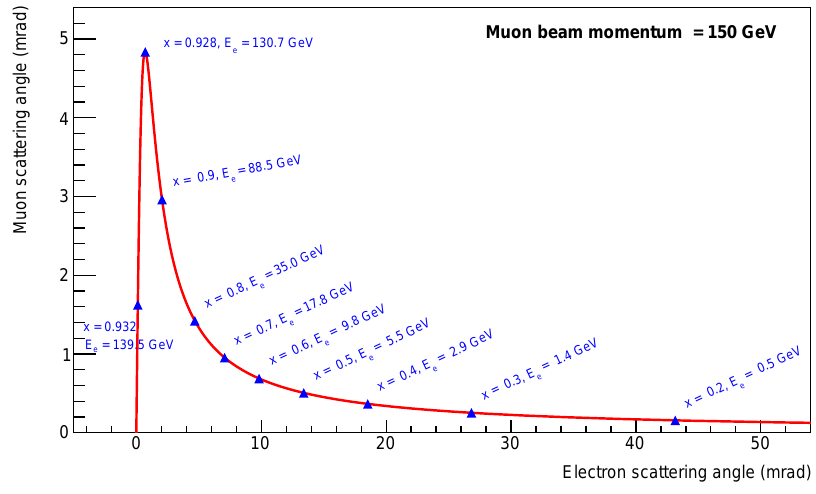
Figure 2. The relation between the muon and electron scattering angles for 150 GeV incident muon beam momentum. Blue triangles indicate reference values of the Feynman’s x and electron